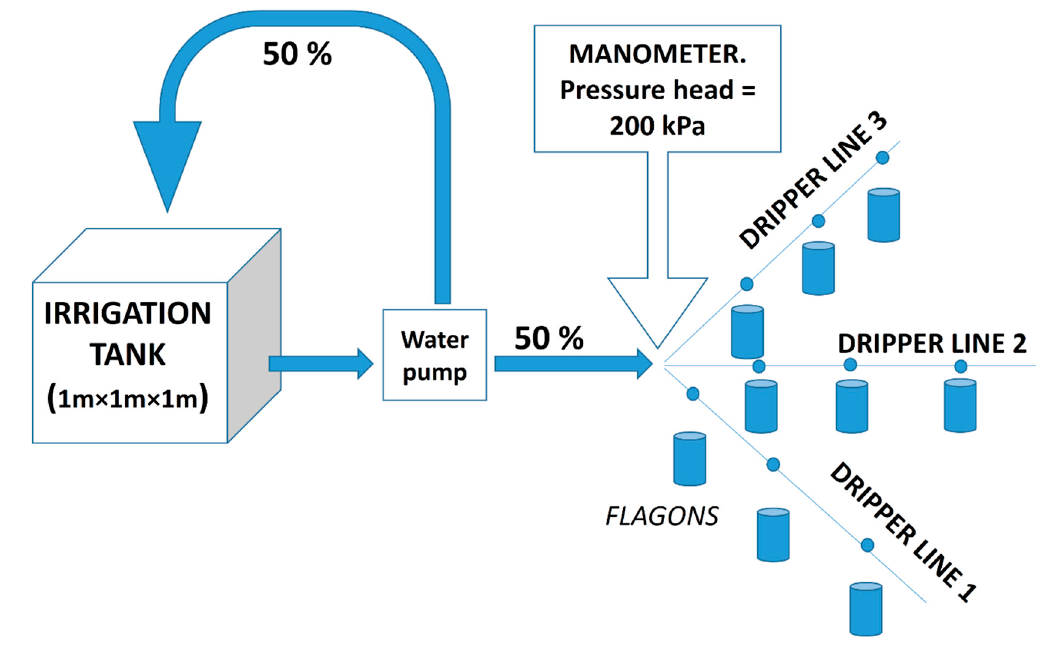
Figure 1. Design of the irrigation tests.